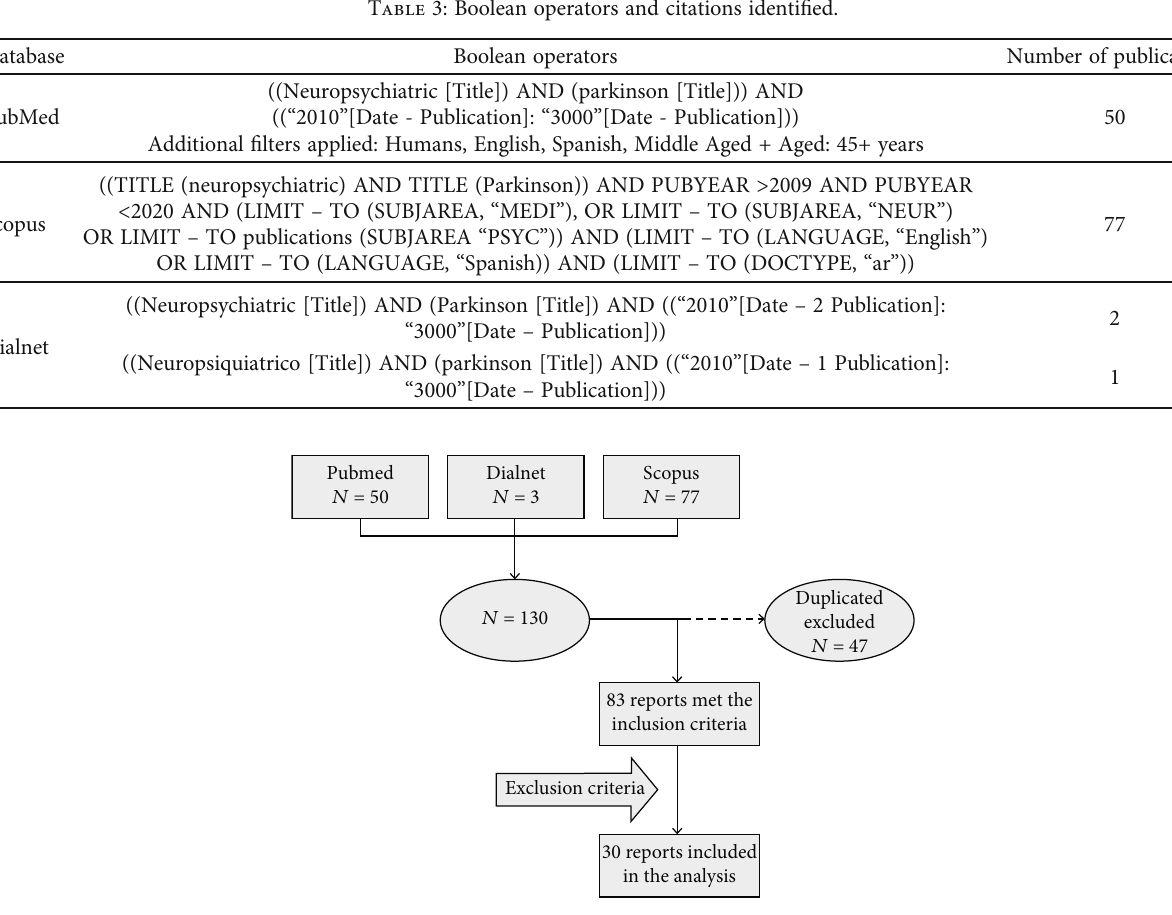
Figure 1: Flowchart of the search strategy and screening process.